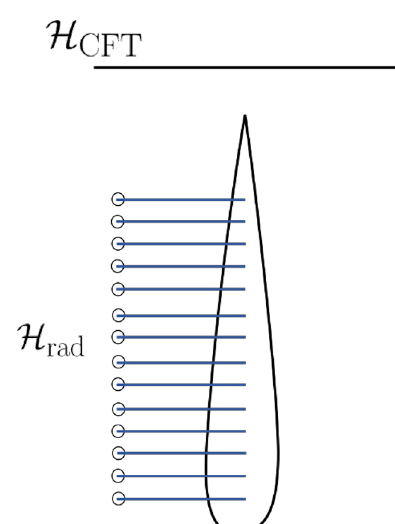
Figure 16. After the black hole has completely evaporated, the bulk encoded in the CFT will be in the vacuum state. However, we can choose a (disconnected) bulk Cauchy slice where the radiation in the reservoir H rad is still be entangled with the pinched-o(cid:11) interior wormhole, which lies in its entanglement wedge. The Ryu-Takayanagi surface is empty and has zero generalised entropy; the two systems H CFT and H rad are therefore